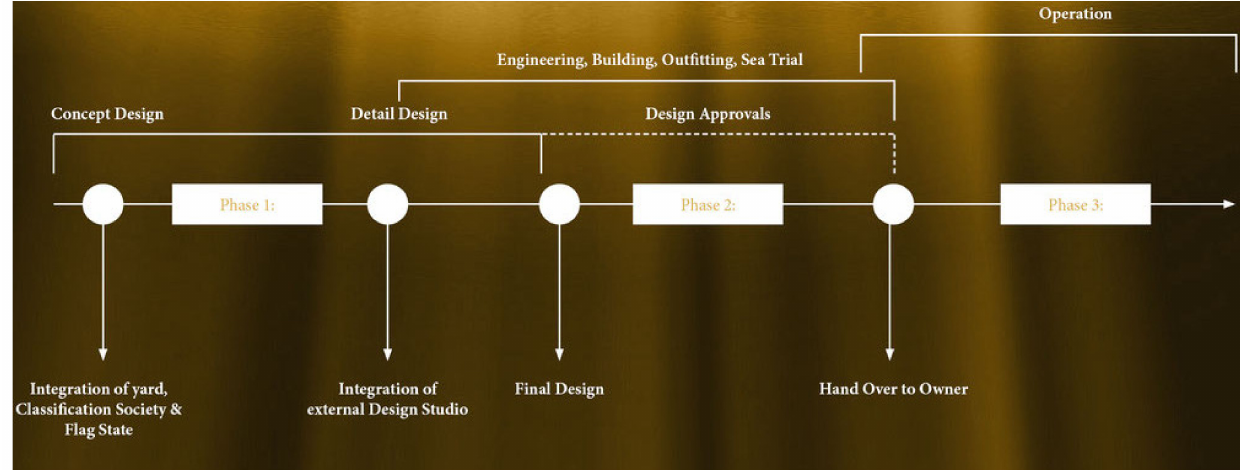
Figure 16. Typical workflow for project management stages used in designing offshore structures, showing concept design, detail design, final design and design approaches (Courtesy: